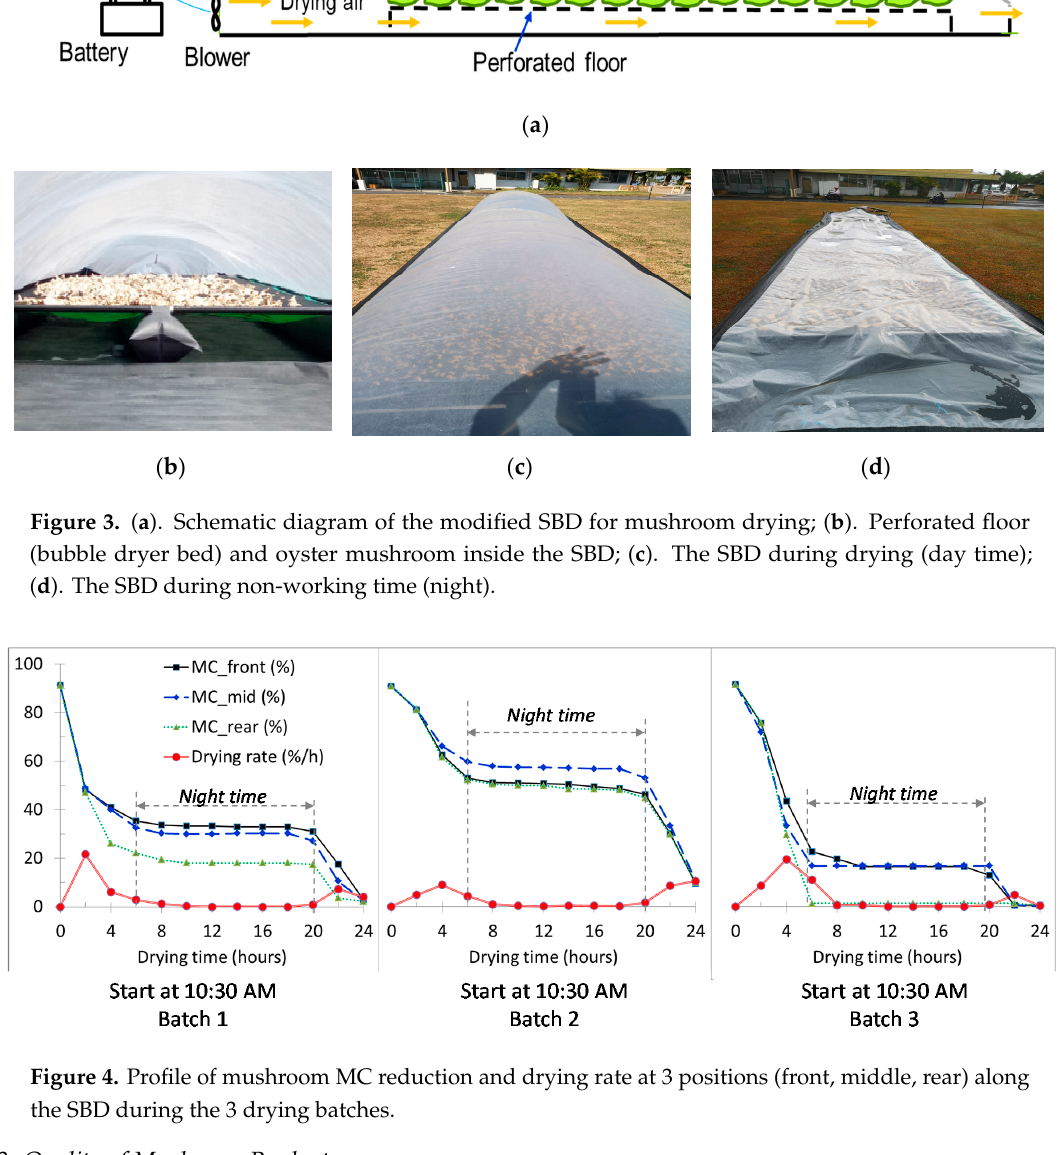
Figure 4. Profile of mushroom MC reduction and drying rate at 3 positions (front, middle, rear) along the SBD during the 3 drying batches.